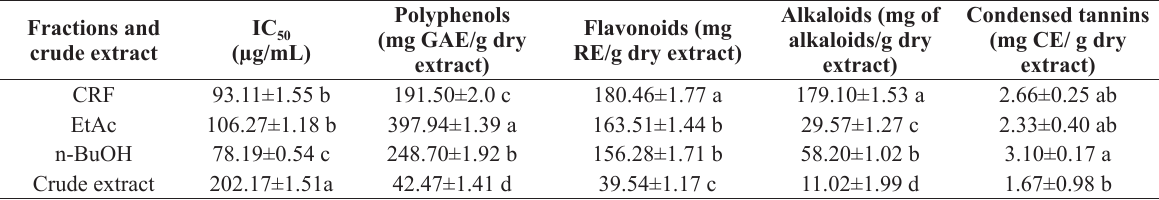
IC and total of polyphenols, flavonoids, alkaloids and condensed tannins 50 in the crude extract and in the fractions of the branches of T. catharinensis . Results are expressed as mean of three determinations ± RSD (relative standard deviation); averages followed by different letters in each column differ by Tukey test at p < 0.001. Alkaloids (mg of Condensed tannins Polyphenols Flavonoids (mg Fractions and IC 50 alkaloids/g dry (mg CE/ g dry (mg GAE/g dry RE/g dry extract) crude extract (µg/mL) extract) extract)